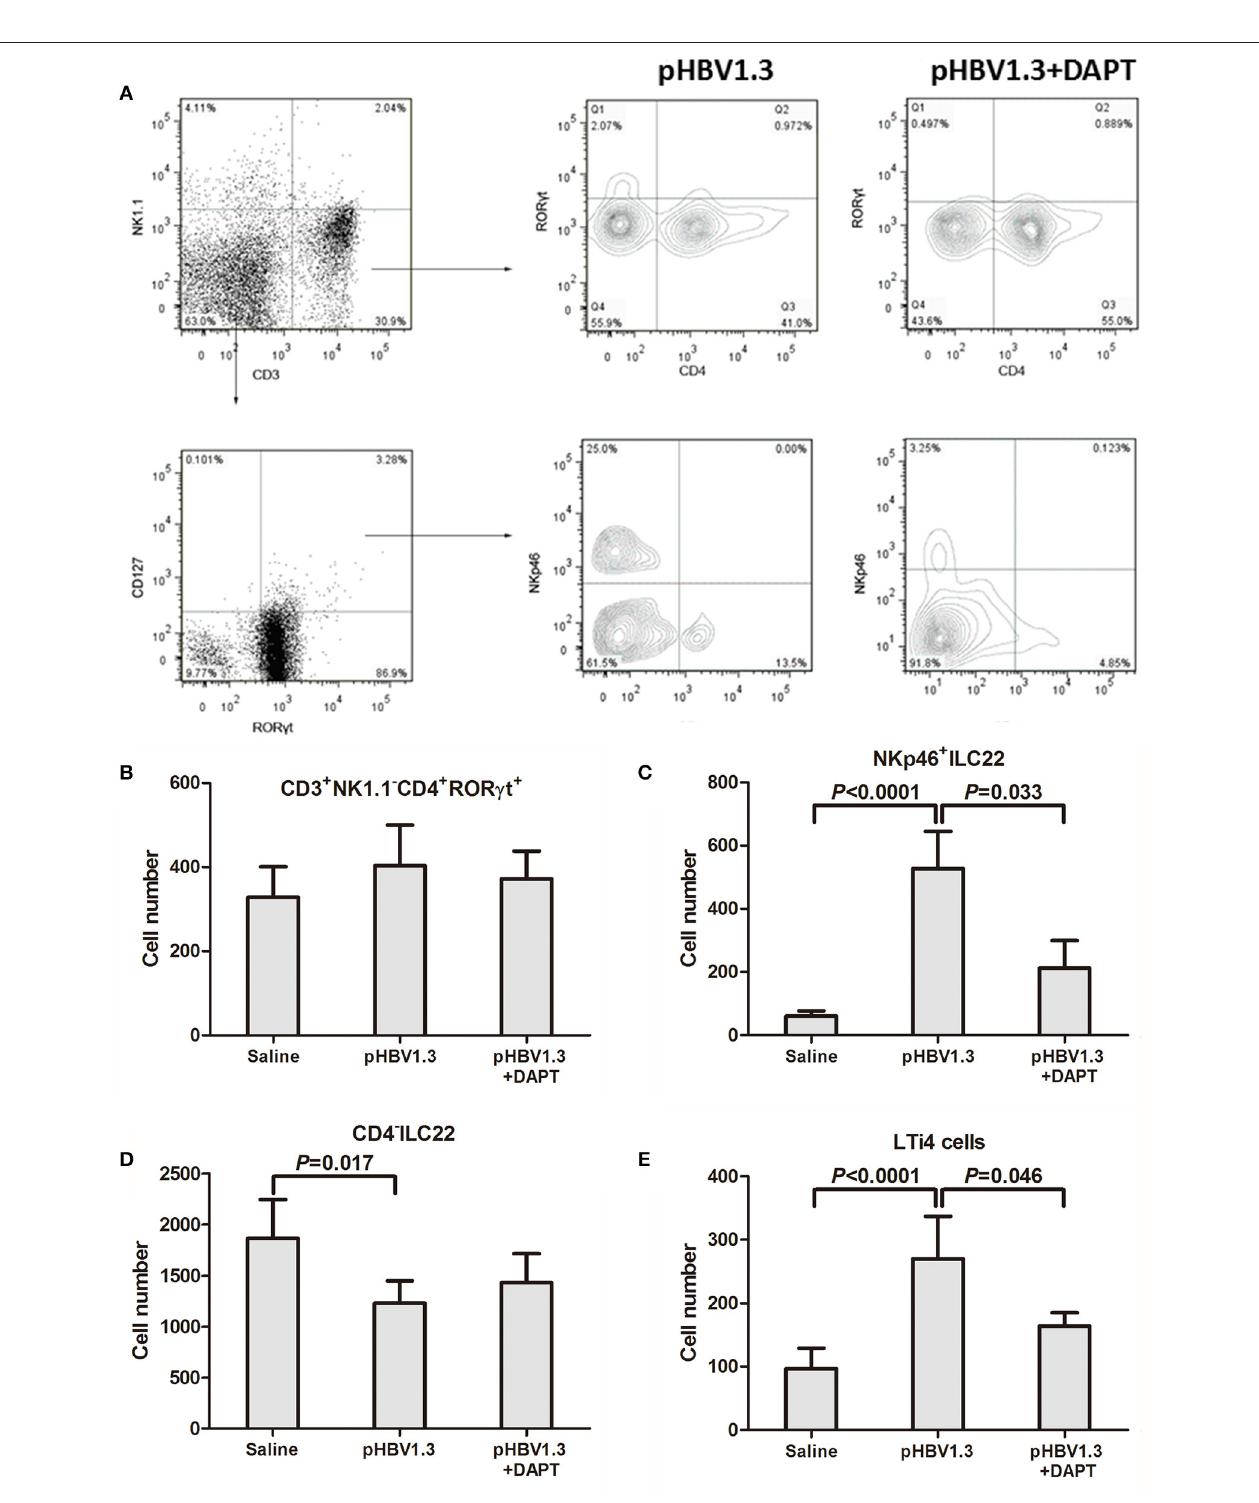
FIGURE 3 | Inhibition of Notch signaling reduced the intrahepatic NKp46 + ILC22 and LTi4 cells. (A) Populations in IHLs were discriminated based on expression of CD3, NK1.1, CD127, ROR γ t, NKp46, and CD4. These included populations of CD3 + CD4 + NK1.1 − ROR γ t + (mostly Th17 and Th22 cells), CD3 − NK1.1 − ROR γ t + CD127 + NKp46 + CD4 − ILC22, and ROR γ t + CD127 − NKp46 − cells (CD4 + and CD4 − ). Representative experiments of flow cytometry is shown. Numbers of (B) CD3 + CD4 + NK1.1 − ROR γ t + cells, (C) NKp46 + ILC22, (D) CD4 − ILC22, and (E) LTi4 cells are shown. All values are presented as the average from each group, and error bars represent SE.